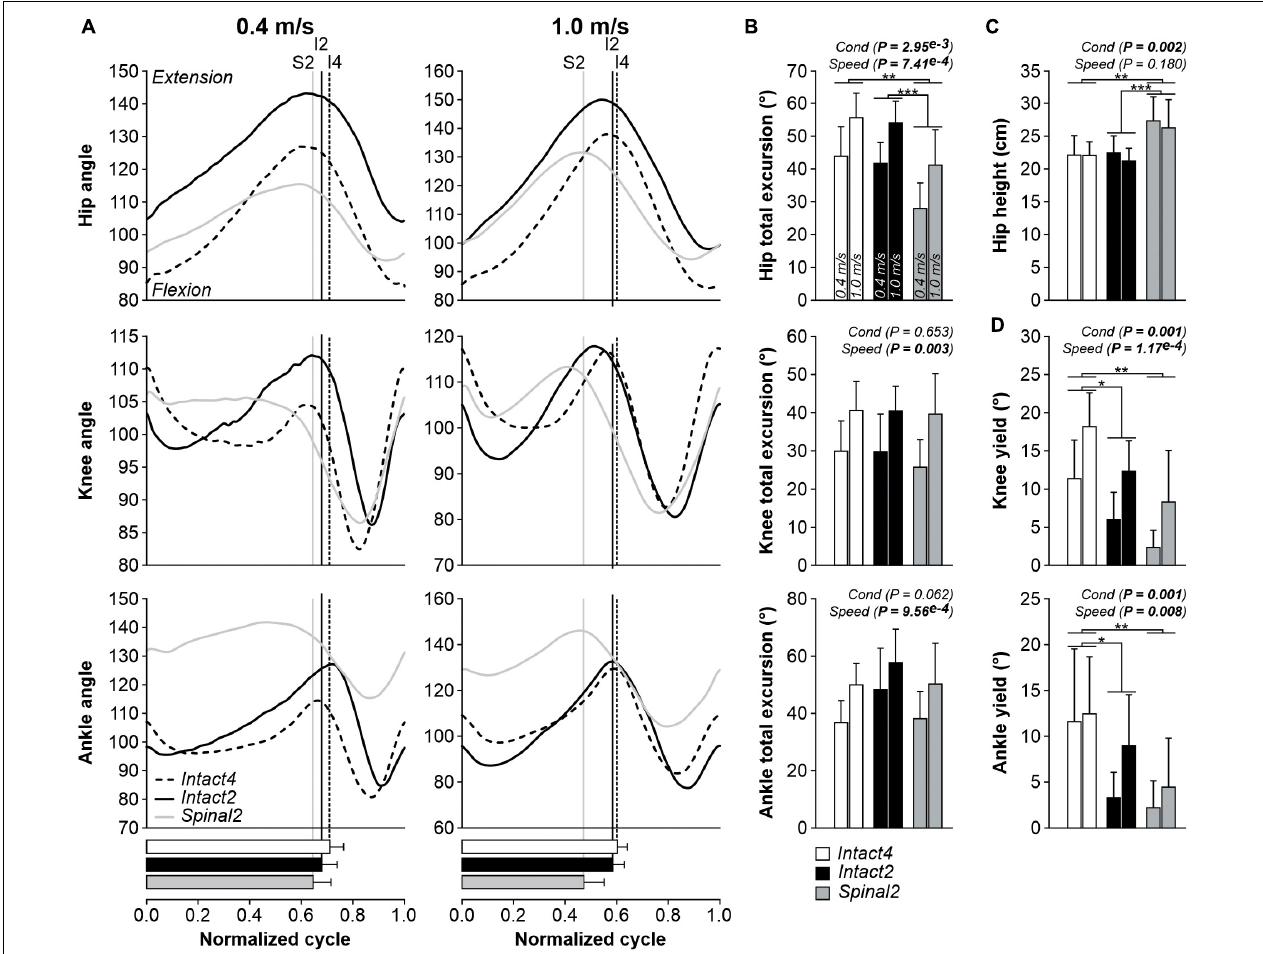
FIGURE 3 | Modulation of joint kinematics during quadrupedal or hindlimb-only locomotion in intact and spinal cats across speeds. (A) Angles of the hip, knee and ankle joints as a function of the normalized cycle during Intact4, Intact2 and Spinal2 conditions at 0.4 and 1.0 m/s. (B) Total excursions of the hip, knee and ankle joints at 0.4 and 1.0 m/s. (C) Height of the hip marker in the three conditions at 0.4 and 1.0 m/s. (D) Yield of the knee and ankle joints at 0.4 and 1.0 m/s. At each speed, 6–15 cycles were averaged per cat. In panel (A) , each line represents the mean for the group ( n = 9 cats). Horizontal bars represent mean stance durations normalized to the cycle and vertical lines indicate paw liftoffs. In panels (B–D) , each data bar shows the mean ± SD for the group ( n = 9 cats). P values comparing conditions (Cond) and speeds are indicated (main effects of repeated-measures ANOVA). One, two or three asterisks indicate a significant difference of the pairwise comparison at P < 0.05, P < 0.01 or P < 0.001,